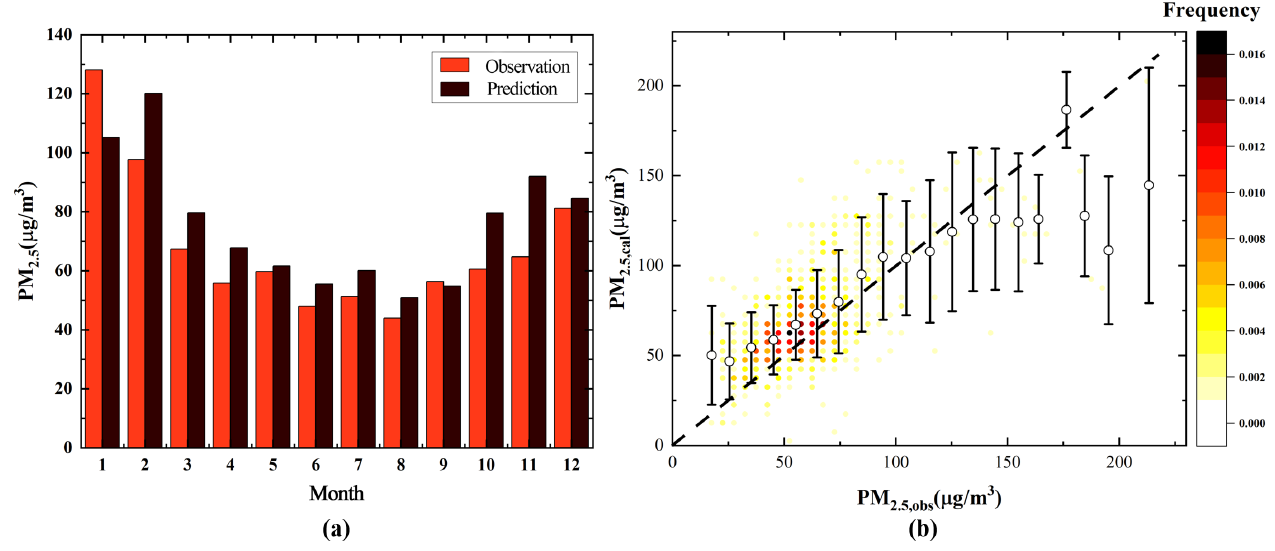
Figure 4. ( a ) The inter-monthly changes of satellite-derived PM 2.5 mass concentration with ground- based values in Beijing, Tianjin, Hebei, and Shanxi in 2017. ( b ) Validation of satellite-derived monthly PM 2.5 mass concentration in 2017. The total number of samples is 1680, and the color scale indicates the frequency of the samples at each gear (5 μg/m 3 ). The black dashed line represents the 1:1 line. Circles and error bars represent the statistical mean and standard deviation of the samples over each statistical interval (10 μg/m 3 ).